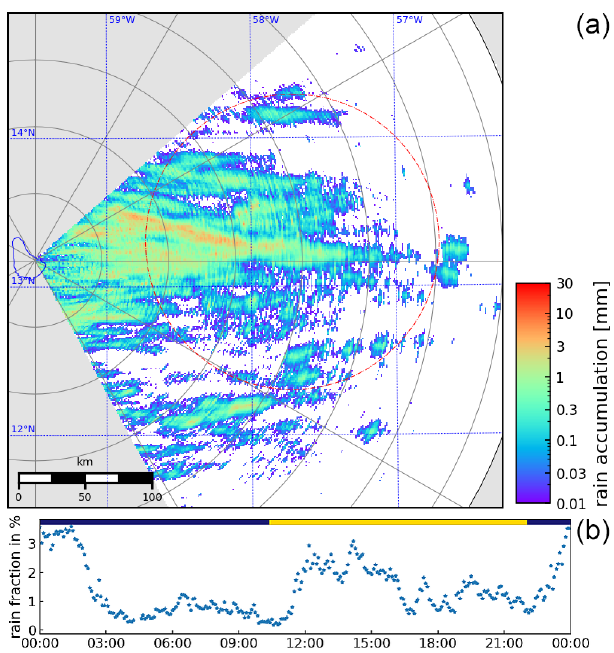
Figure 9. 9 February 2020. (a) Daily rain accumulation; red cir- cle denotes the HALO circle pattern. (b) Percentage of precipitation area within the HALO circle pattern; times are in UTC. Blue/yellow bar on top indicates night/day at Barbados.